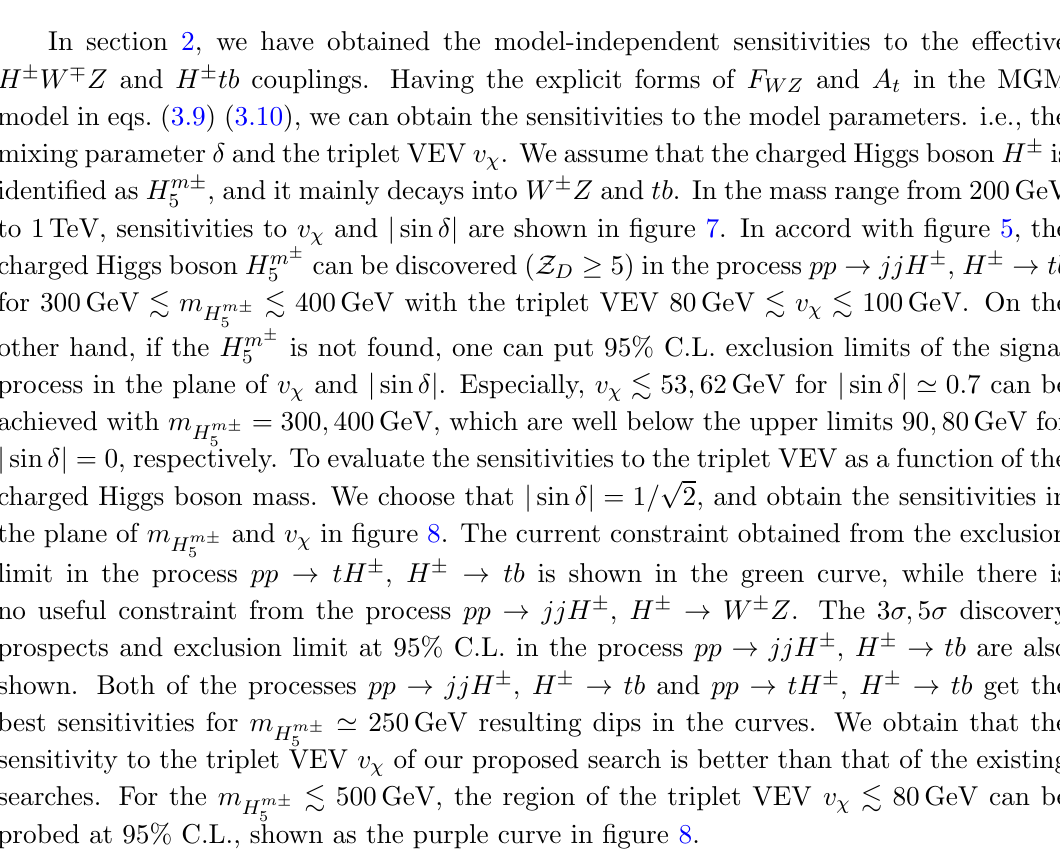
Figure 6 . Constraints on the triplet VEV v (cid:31) as well as sine of the mixing angle (cid:14) in the MGM model with the assumption m = 3 m . The mass of charged Higgs boson H m + H m + 3 H m + 5 to be 200 ; 500 ; 1000 GeV from left to right panels. The region on the left of the blue (red) curve is allowed at 1 (cid:27) (2 (cid:27) )